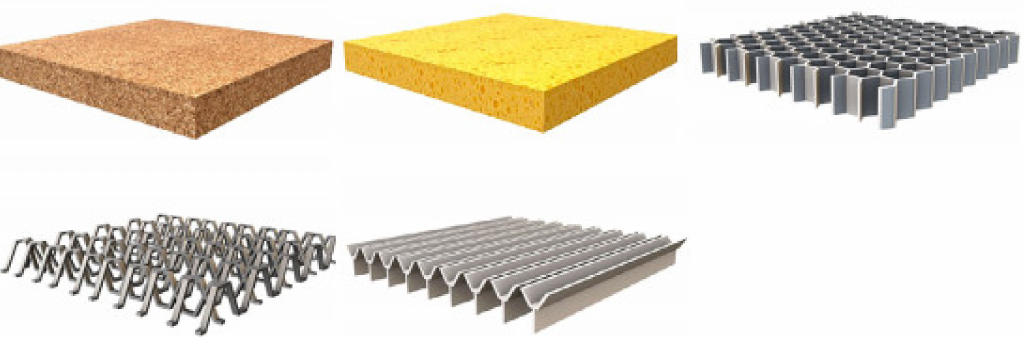
Figure 2. Examples of core shapes for sandwich structures [51].